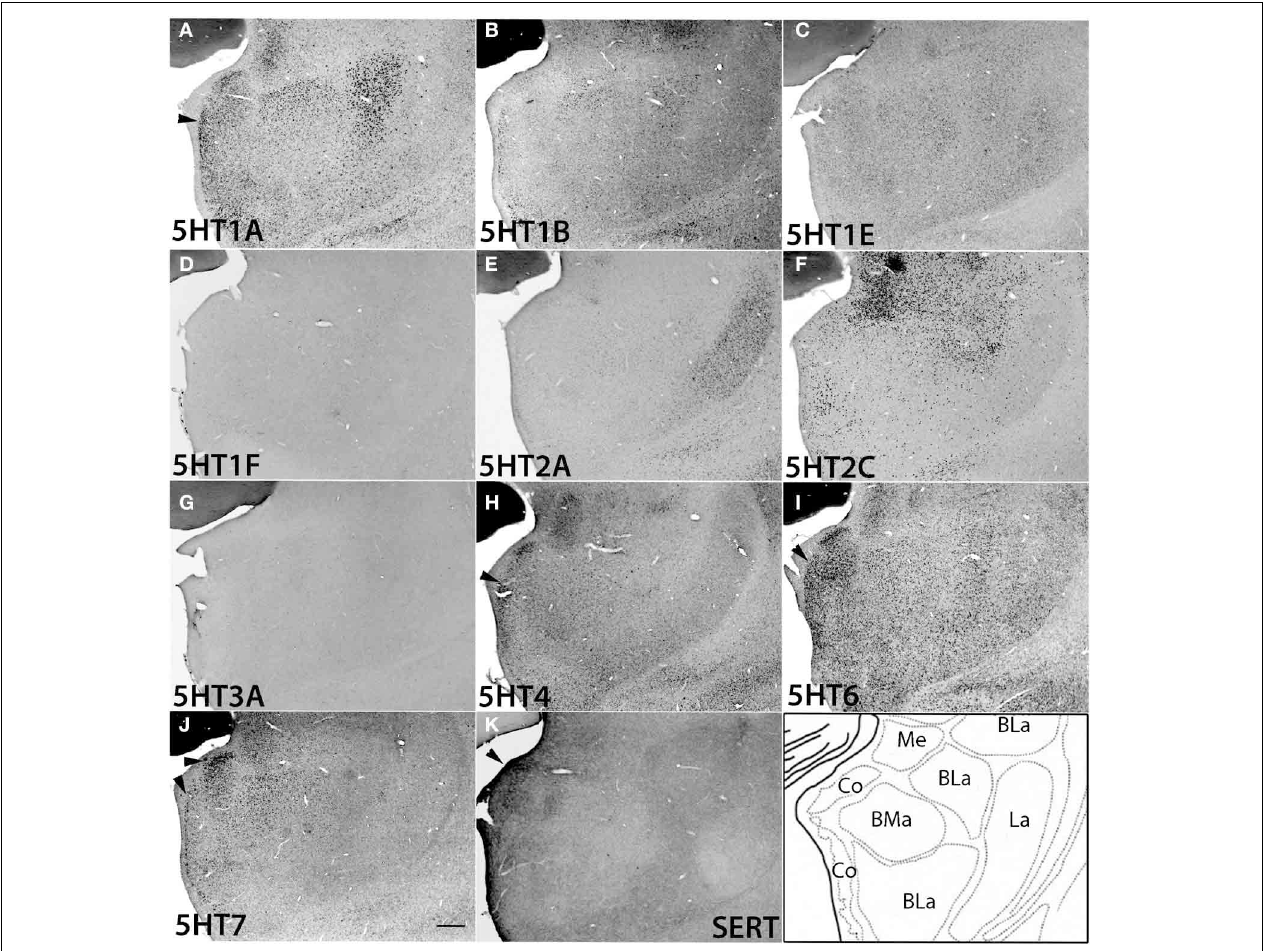
FIGURE 10 | ISH expression profiles of 5HTR s in amygdala. 5HTR mRNA expressions (A–J) and immunohistochemical staining with anti-SERT antibody (K) in basomedial (BMa), basolateral (BLa), cortical (Co), lateral (La), and medial (Me) amygdaloid nuclei of amygdala. Note